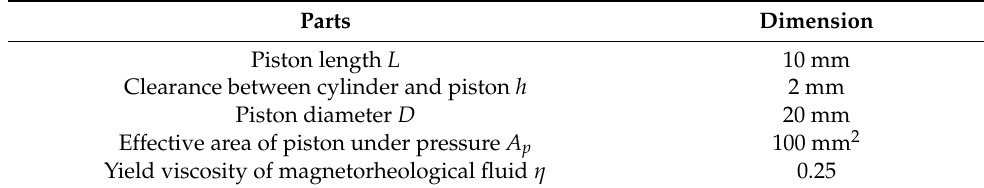
Figure 10. Comparison of the SMC, PID and the passive system under normal distributed random signal: ( a ) time domain curve; ( b ) spectrum. Table 2. The parameters of the